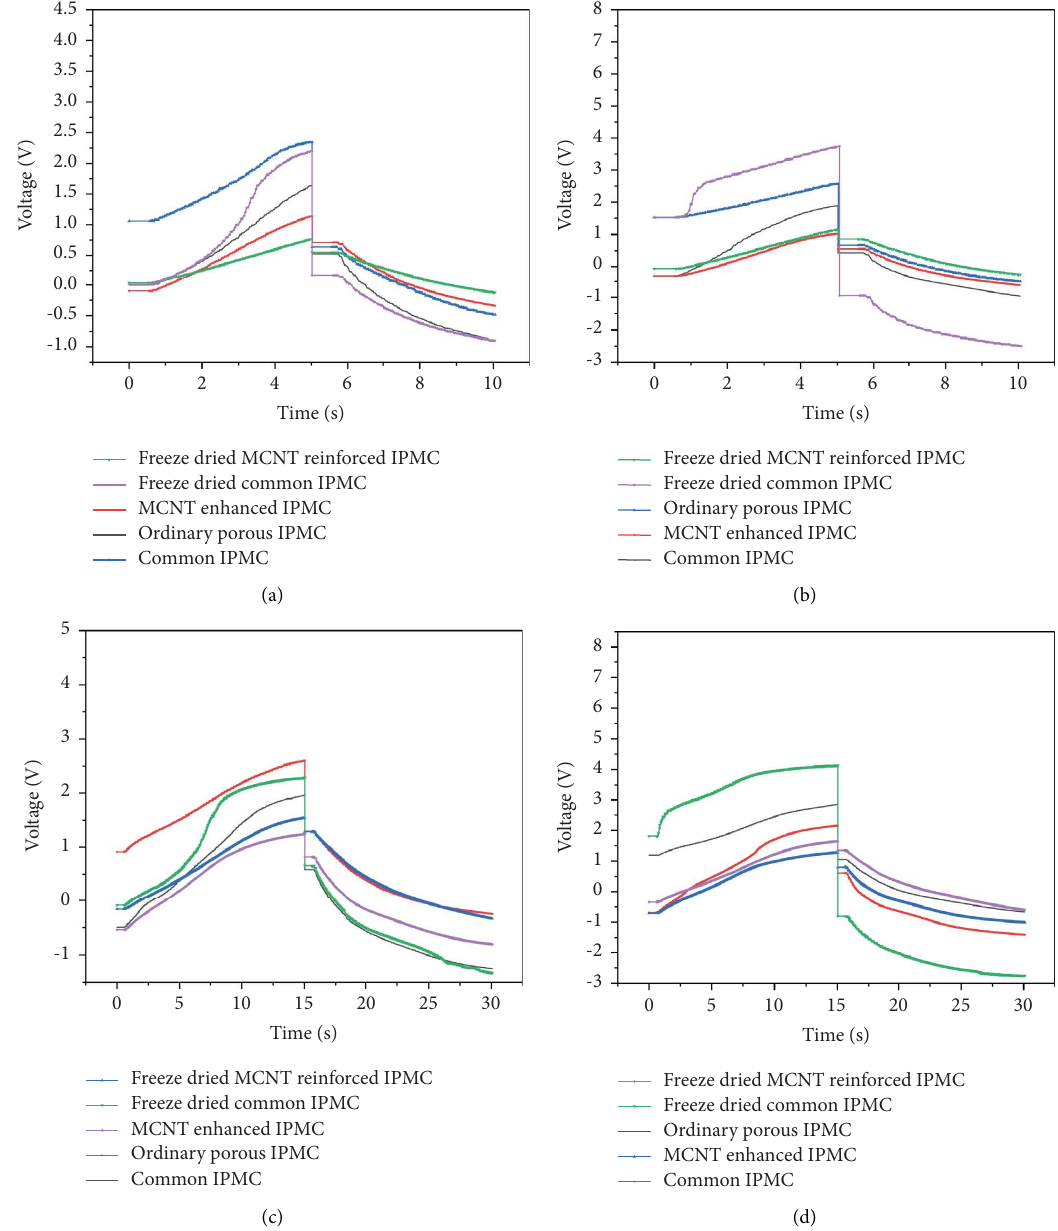
Figure 9: GCD curve of current in diferent sections: (a) 10 s interval, 1mA; (b) 10 s interval, 1.5mA; (c) 30s interval, 1 mA; (d) 30s interval,